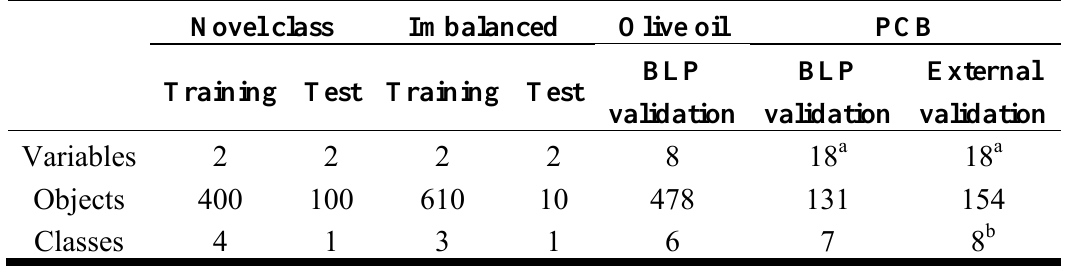
Table 4. Similar to the latent variables used in the PLS-DA models, the numbers of hidden neurons used to train SCRBFN and RBFCCN models may vary between different runs. Therefore, only typical latent variables and numbers of hidden neurons are reported. Table 3. The numbers of variables, objects, and classes of the data sets evaluated.